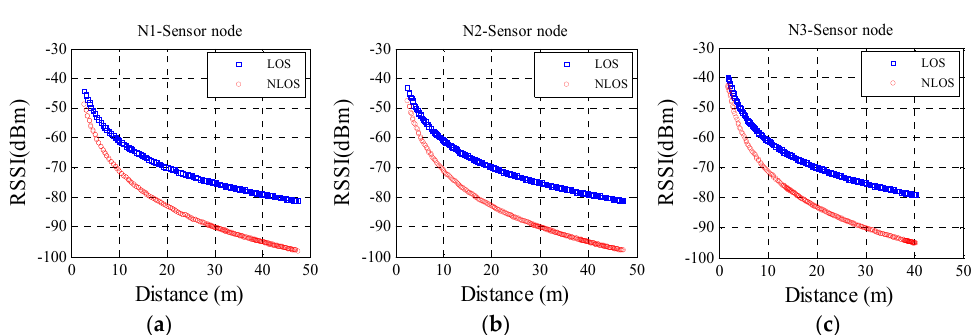
Figure 5. Path loss between beacon nodes and sensor node for LOS and NLOS ( a ) N1-sensor node, ( b ) N2-sensor node, and ( c ) N3-sensor node.